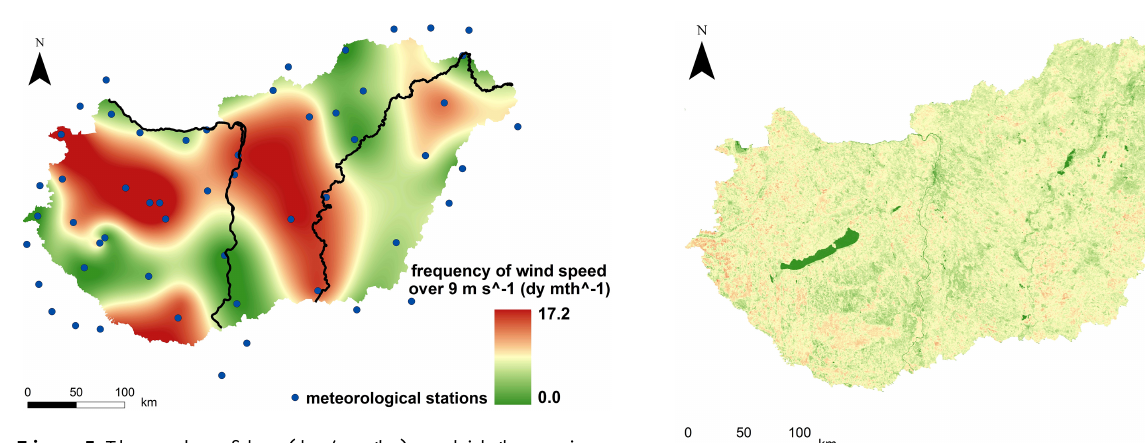
Figure 5. The number of days (day/months) on which the maximum wind speed is over 9ms − 1 in March–April in the period of 2000– 2011. Figure 6. NDVI map from 250m resolution MODIS (average val- ues from March–April (in the period of 2000–2011) generated from the 16-day